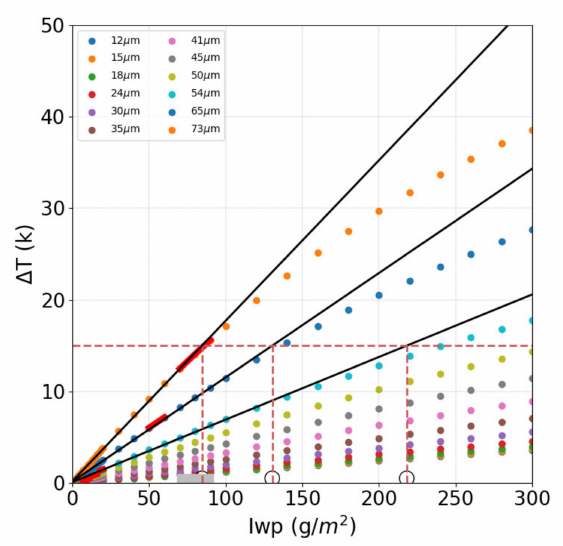
Figure 3. The diagram of the method used in the algorithm to retrieve IWP.